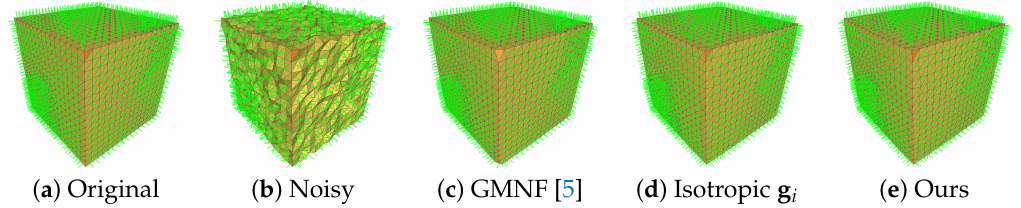
Figure 3. Comparison of denoising results using different guidance